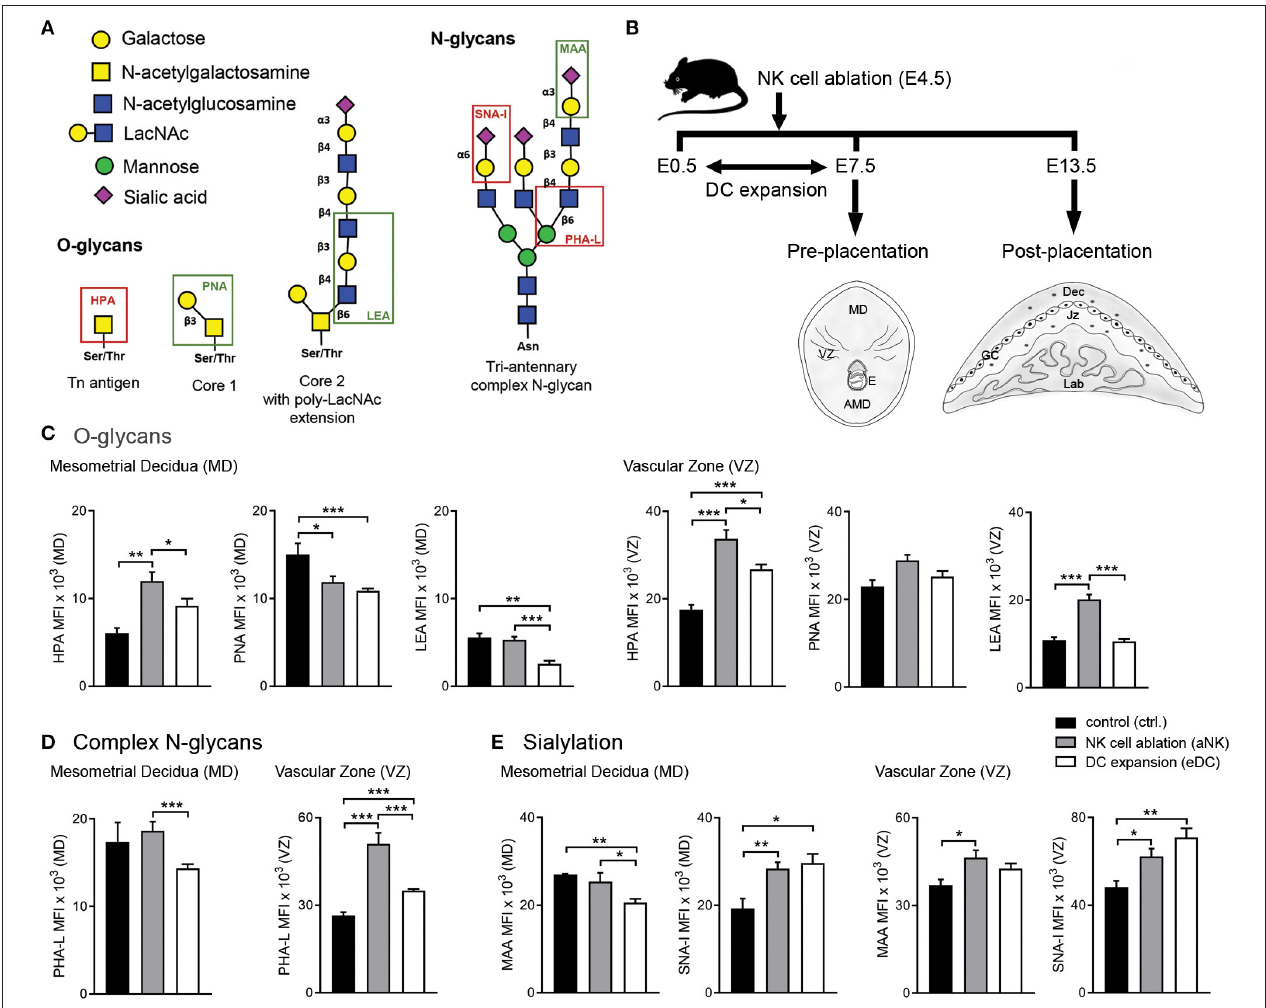
FIGURE 1 | Influence of NK cell depletion and DC expansion on the glycophenotype of implantation sites during the pre-placentation period. (A) For analysis of the glycophenotype, lectins were used to detect different types of glycosylation. O-glycan structures were recognized by Helix pomatia agglutinin (HPA; Tn-antigen), Arachis hypogaea lectin (PNA; core 1), and L ycopersicon esculentum lectin (LEA; core 2). In addition, we employed Phaseolus vulgaris lectin (PHA-L), which specifically recognizes β 1-6GlcNAc-branched complex N-glycans. Finally, sialyation was determined using the Maackia amurensis lectin (MAA) and Sambucus nigra agglutinin (SNA-I) which bind to α 2,3- and α 2,6-linked sialic acid, respectively. (B) Experimental design: pregnant CD11c.DTR females were injected (i.p.) on E4.5 with anti asialo GM1 for transient ablation of NK cells. For the expansion of uterine DC, pregnant CD11c.DTR females were treated with one daily injection of FL (10 mg/mouse/day) from E0.5 to E7.5 as described in material and methods. Pre- (E7.5) and post-placentation (E13.5) period implantation sites were included in the glycodynamics analysis. (C–E) Quantification of O-glycan (C) , complex N-glycan (D) , and sialylated glycan (E) mean fluorescence intensity (MFI) in the mesometrial decidual (MD), and vascular zone (VZ) of implantation sites following NK cell ablation or DC expansion during the pre-placentation stage. In all figures, data shown are mean ± S.E.M. and differences are denoted as * P < 0.05, ** P < 0.01, and *** P < 0.001, as analyzed by Mann-Whitney U-test . AMD, antimesometrial decidua;